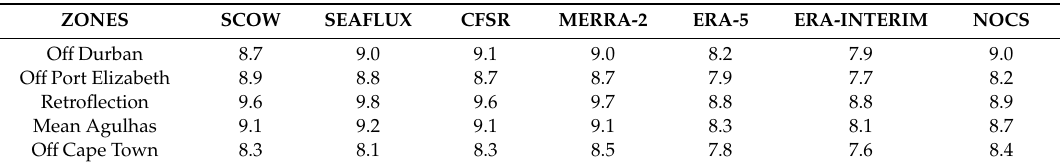
Table 4. Same as Table 2 but for the surface wind speed (m / s). The products are averaged using the resampled data on the grid of SCOW (0.25 ◦ × 0.25 ◦